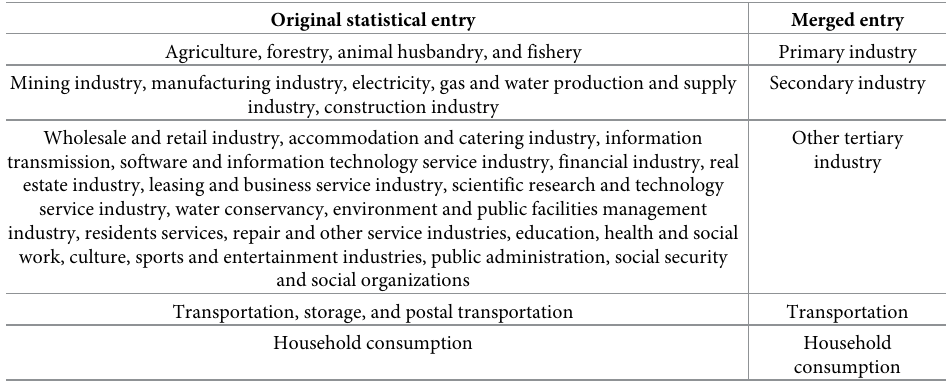
Table 2. Consolidated results of industry